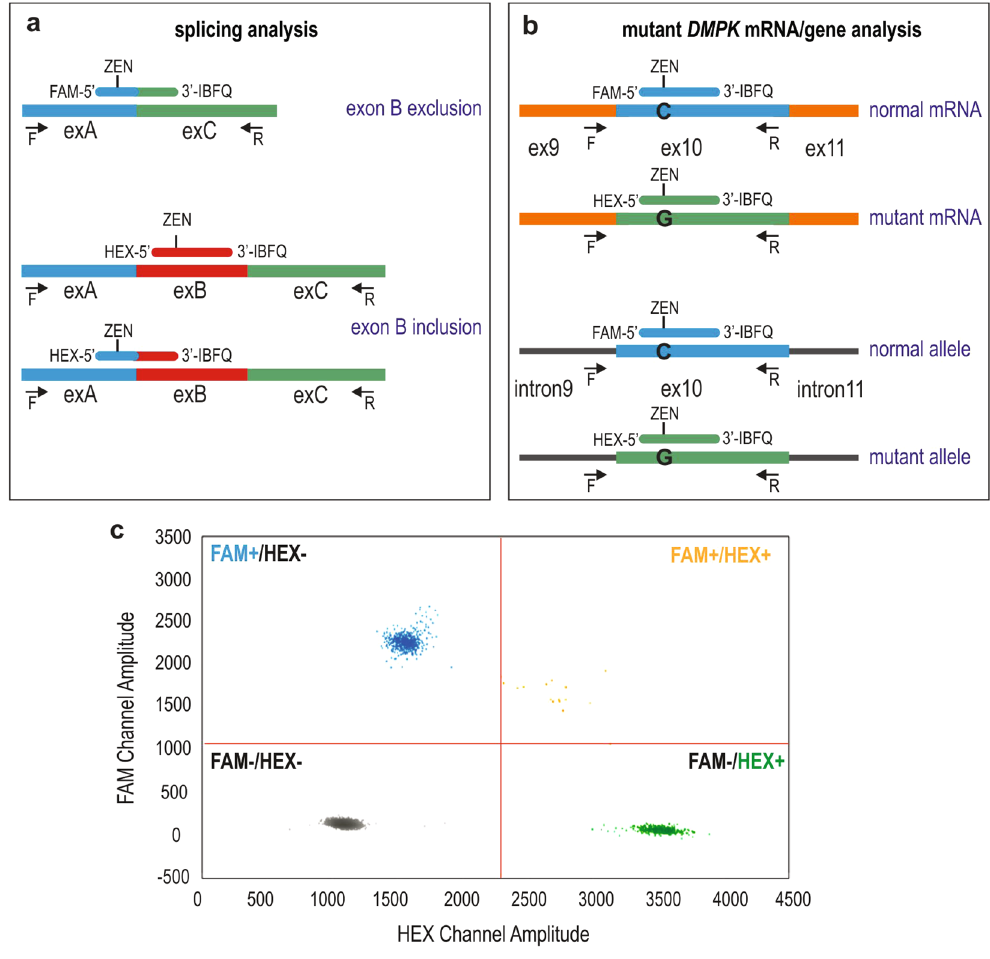
Figure 3. ddPCR Probes Used. ( a ) An alternative exon exclusion probe (FAM-labeled) and two alternative exon inclusion probes (HEX-labeled) used in alternative splicing assays; the probes have ZEN-Iowa Black as the dual- quencher. An alternative exon (exB) is indicated in red, and it’s flanking exons (exA and exC) in blue and green. Location of primers (F and R) is shown by arrows and ZEN probes are displayed in their binding exons. ( b ) Dual- quencher probes used in DMPK copy number quantification in cDNA (upper part) and gDNA (lower part). The rs527221 SNP in exon 10 of DMPK was used to distinguish normal-size and mutant alleles. Position of primers (F and R) is shown by arrows and probes are displayed in their binding sites. ( c ) Representative 2-dimensional scatter plot displaying droplet populations in separate clusters depending on their fluorescence amplitude following ddPCR for CACNA1S exon 29 (DM2 sample). FAM-positive droplets (FAM + /HEX − ), HEX-positive (FAM − /HEX + ), double-positive (FAM + /HEX + ), and negative droplets (FAM − /HEX − ) are